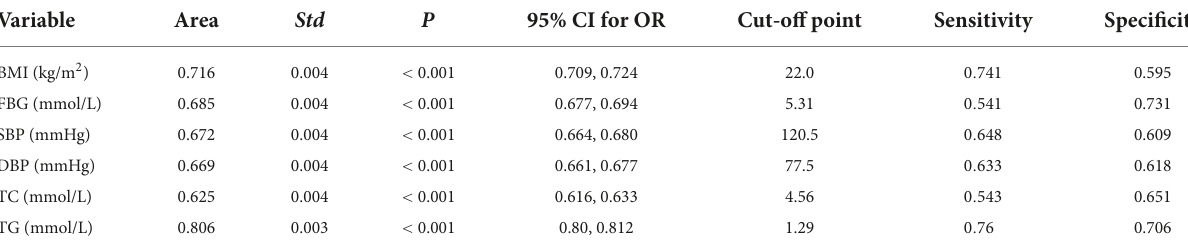
TABLE 5 Receiver operating characteristic (ROC) curve evaluation of the diagnostic efficacy of each index in diagnosing non-obese fatty liver disease (FLD). Variable Area Std P 95% CI for OR Cut-off point Sensitivity